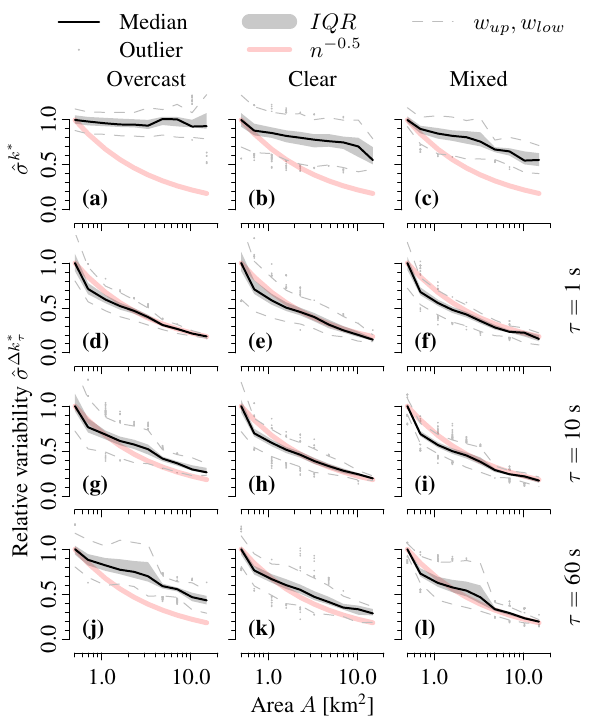
∗ ∗ and ˆ σ (cid:49)k τ in clear- Figure 8. Normalized standard deviations ˆ σ k sky index k ∗ (a – c) and its increments (cid:49)k ∗ τ (d – l) as functions of averaging area A for different short-term time lags τ , and condi- tioned on different sky types. The summary statistics (cf. Table 1) are computed for 10 discrete areas that are logarithmically increas- ing in size, and contrasted with the uncorrelated decrease of vari- ability following n − 0 . 5 . The random circle method is used to sam- ple these areas, using 500 different circles for each area bin, and a constant sensor density of 2km − 2 . Samples are drawn from both field campaigns, with the Melpitz campaign only allowing for cir- cles up to about 4.5km 2 of area, and the Jülich campaign covering the entire spatial